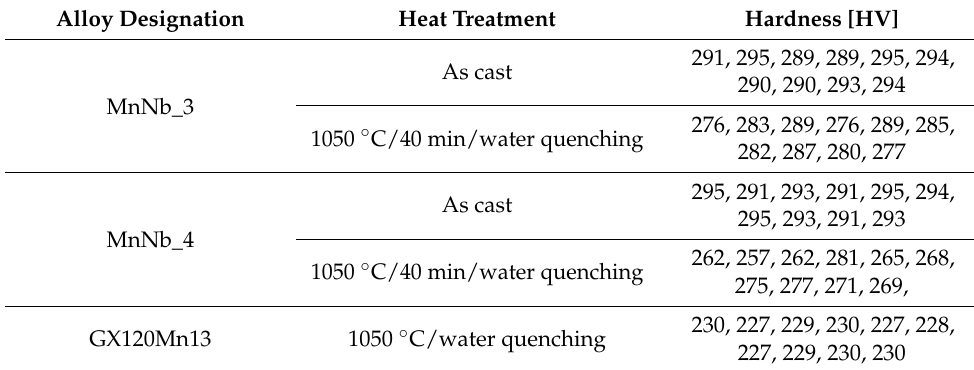
Table 2. Heat treatment of the tested samples and their